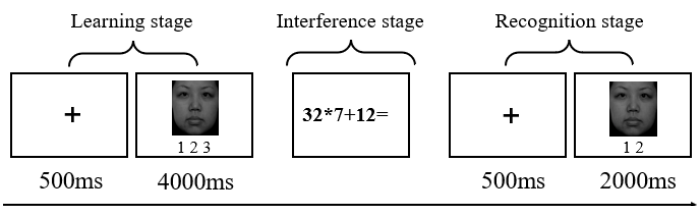
Figure 4. An illustrative example of the memory bias experiment.